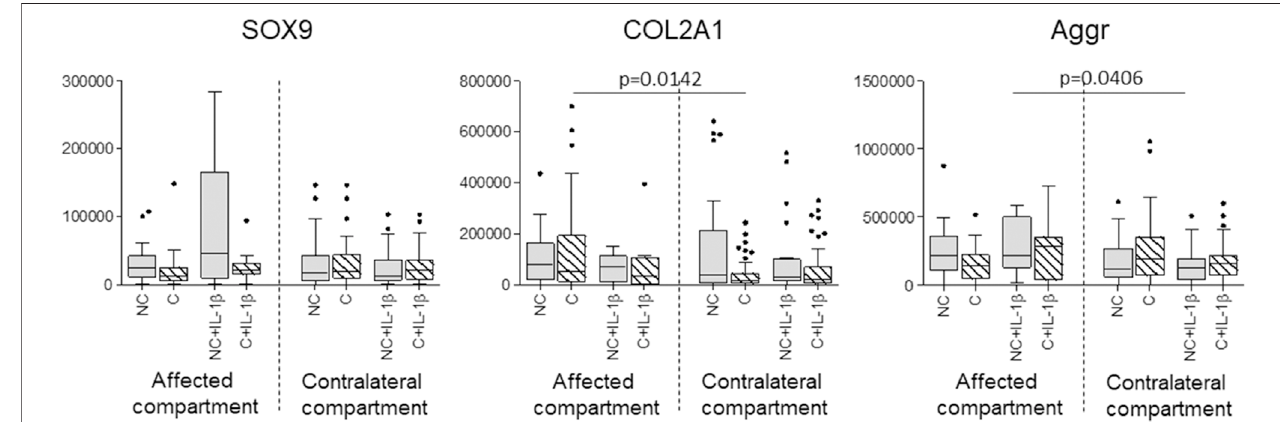
FIGURE 4 | Effect of compression on SOX9, COL2A1, and Aggrecan gene expression in affected and contralateral compartments (Sidak test for multiple comparisons). Data are represented as medians (number of mRNA molecules of the gene of interest/10 5 GAPDH copies). Boxes represent 25 th -75 th percentiles; whiskers represent minimum and maximum values; dots represent outliers. NC= uncompressed; C= compressed; IL-1 β = stimulated with 2 mg/ml IL-1 β .